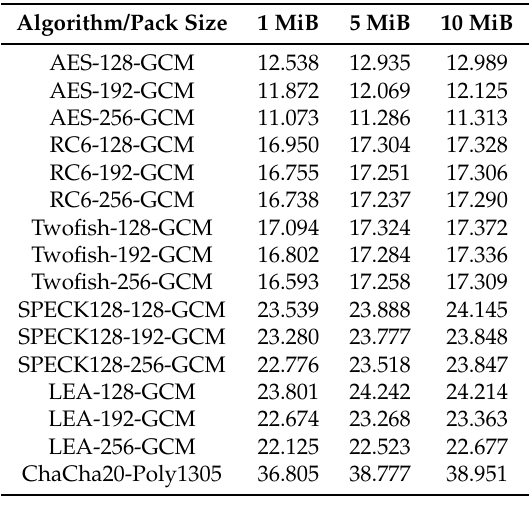
Table 2. Average encryption throughput (MiB/s) in the ARMv7-a Samsung device. Algorithm/Pack Size